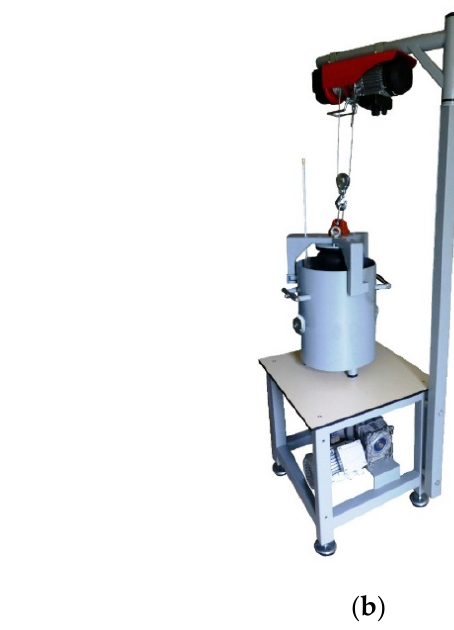
Figure 1. Vane shear tester: schematic of the apparatus with rotor type1 ( a ) and measuring station with lift and balance ( b ).